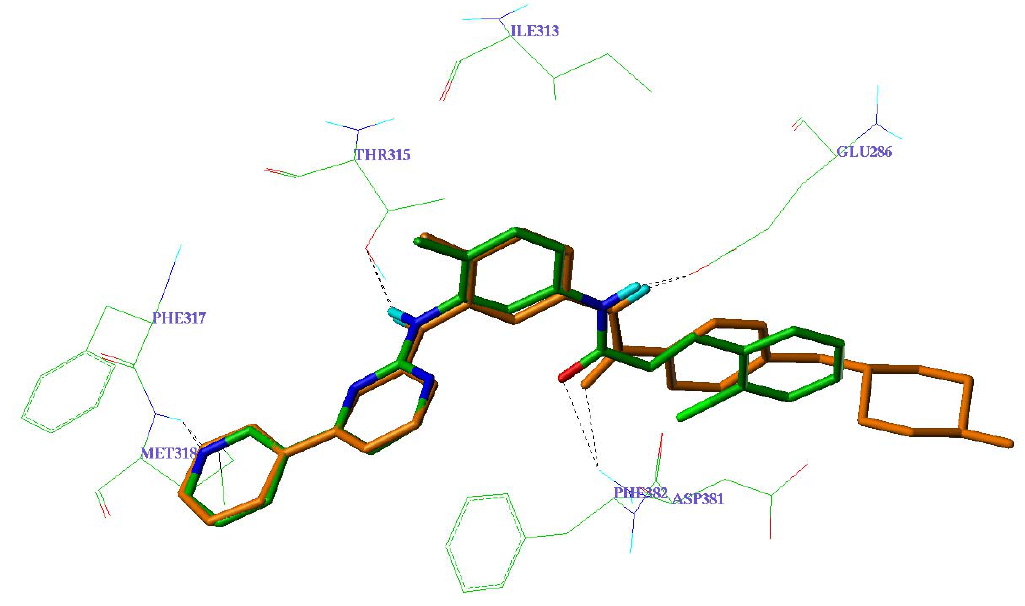
Figure 2. Binding modes of STI-571 (orange; X-ray crystal structure) and compound 12d (green; docked pose) to the c-Abl kinase